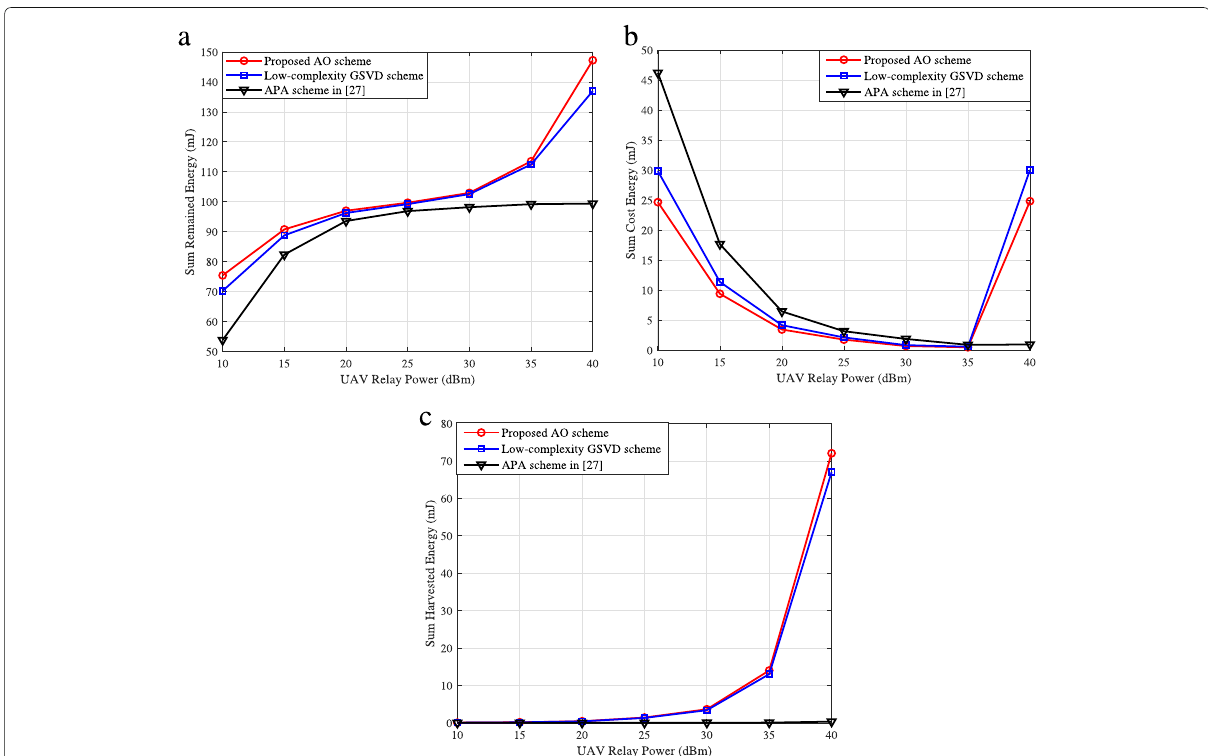
Fig. 4 Various performance results of different schemes versus the maximum transmission power of UAV relay (dBm) P R , Max . a Sum remained energy versus P